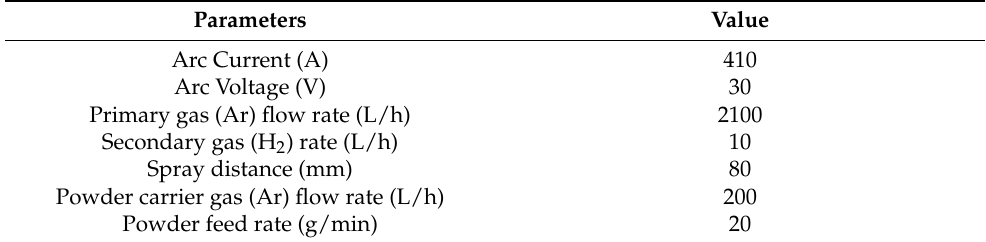
Table 2. Atmosphere plasma spraying